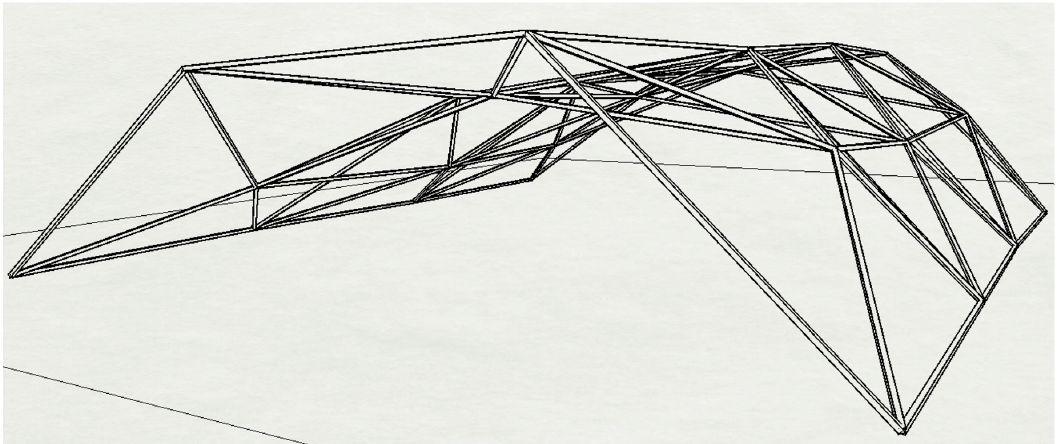
Figure 15. Illustration of the best alternative (Optimus) result for design optimization problem.